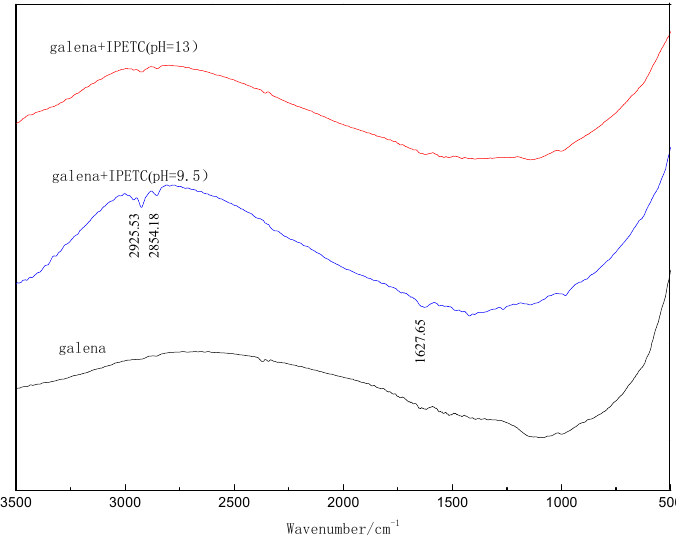
Figure 6. Infrared spectra of galena with IPETC at different pH.